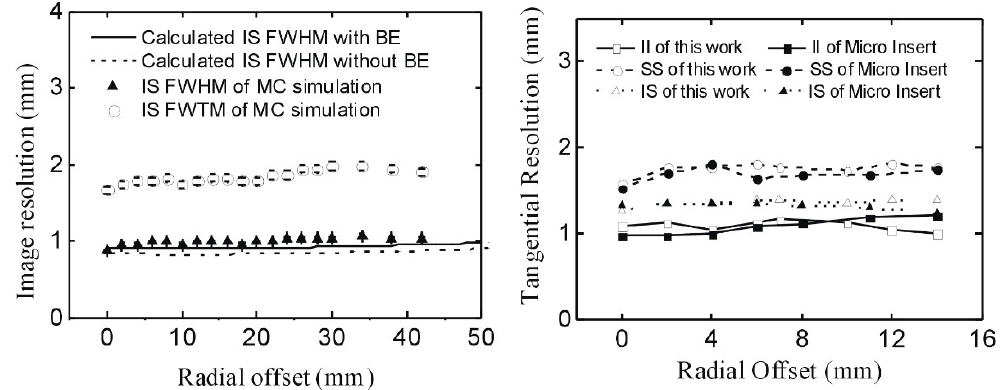
Figure 7. GATE-simulated image resolution of the current prototype PET system compared with the image resolution of the theoretical calculations ( left ) and the image resolution of the micro insert system [2] ( right ).